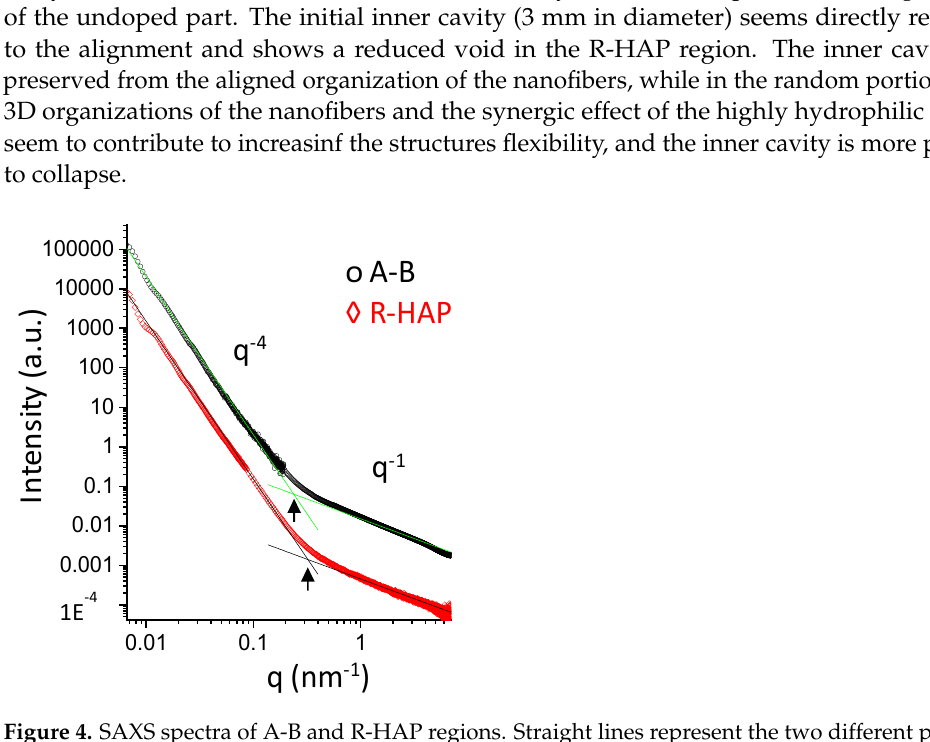
Figure 4. SAXS spectra of A-B and R-HAP regions. Straight lines represent the two different power-low of the scattered intensity decay: I(q) ÷ q − 4 in the low-q range, I(q) ÷ q − 1 for q > 2 × 10 − 1 nm − 1 in the A-B region, and at q > 3 × 10 − 1 nm − 1 in the R-HAP region.